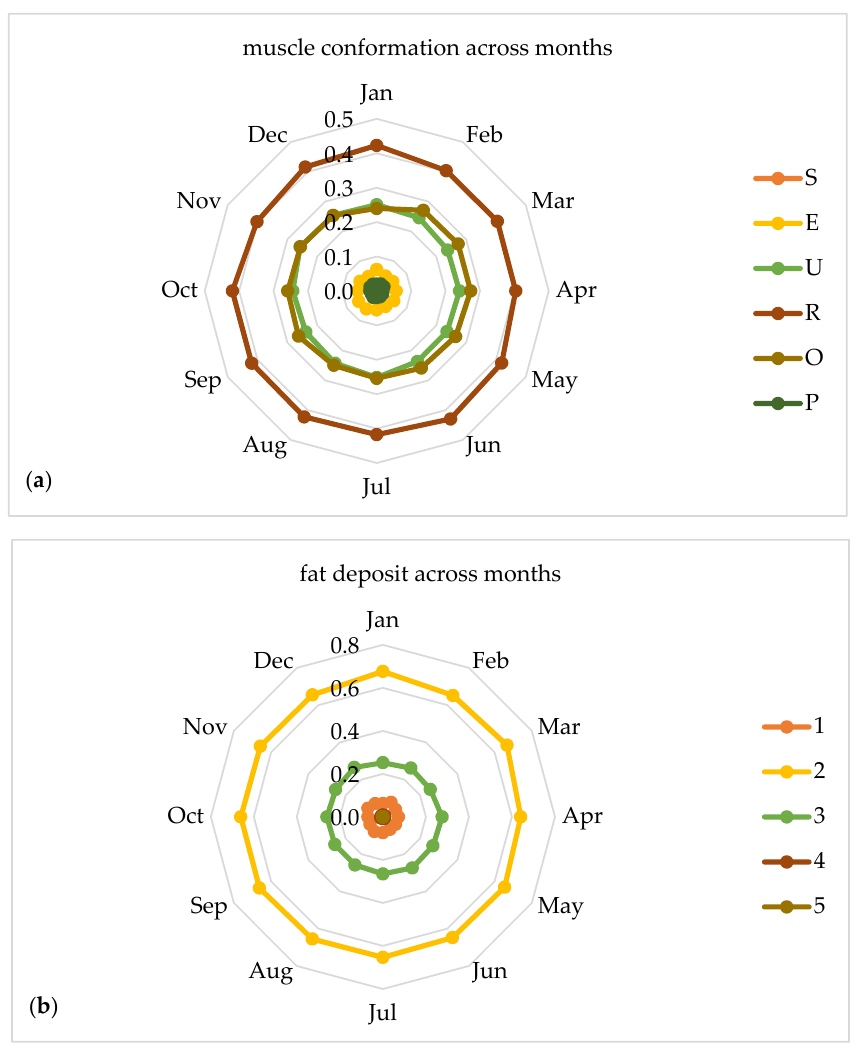
Figure 4. Proportions of muscle conformation ( a ) and fat deposit ( b ) classes distributed across 12 months.